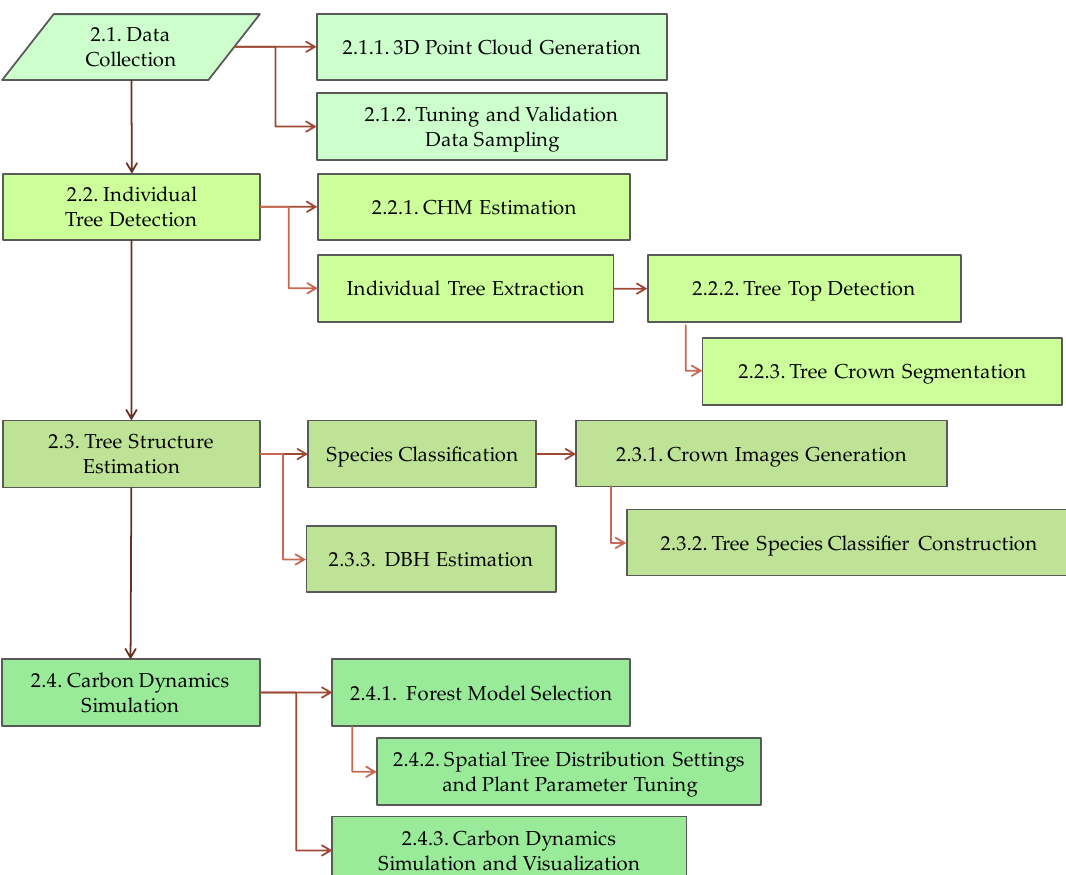
Figure 2. An overall flowchart in data collection, individual tree detection, tree structure estimation, and carbon dynamics simulation. The main processes are shown in the left and sub processes of each main process are described as arrows indicate. The numbers in each process correspond to section numbers.